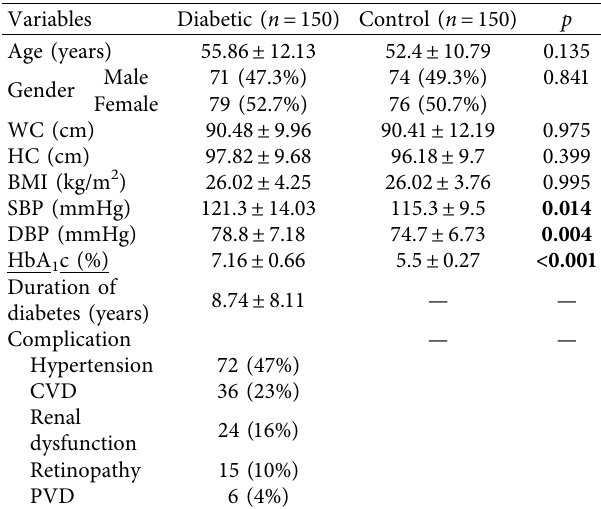
Table 1: Comparison of means of various demographic and an- thropometric data between diabetic and healthy control.